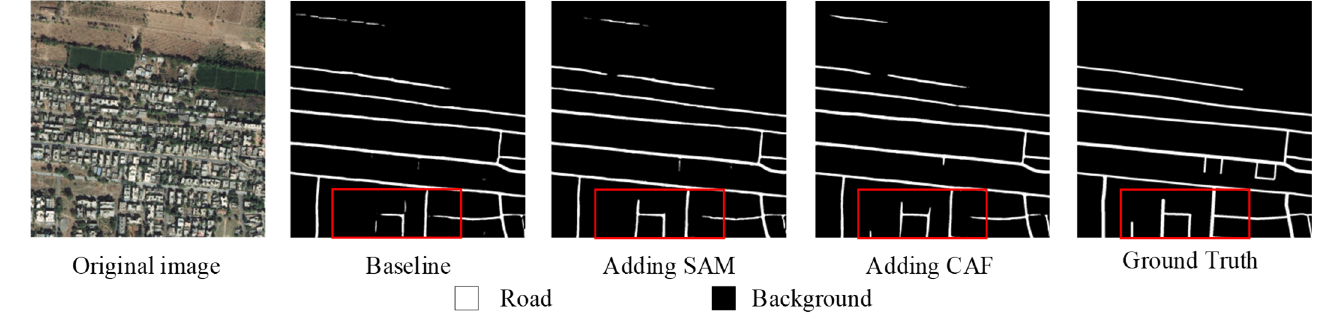
Figure 13. Comparison of visual results of module validity analysis based on DeepGlobe dataset.